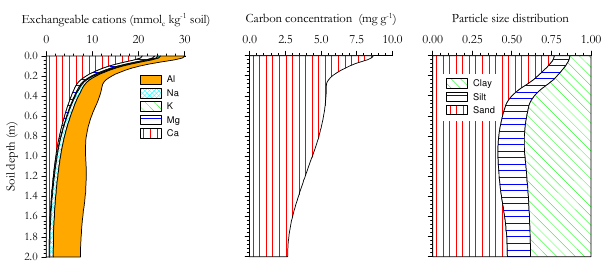
Fig. 11 Fig. 11. Profiles of exchangeable cations, soil carbon and texture for a Vetic Acrisol (Hyperdystric) at Mato Grosso state, Brazil (ALF- 01).